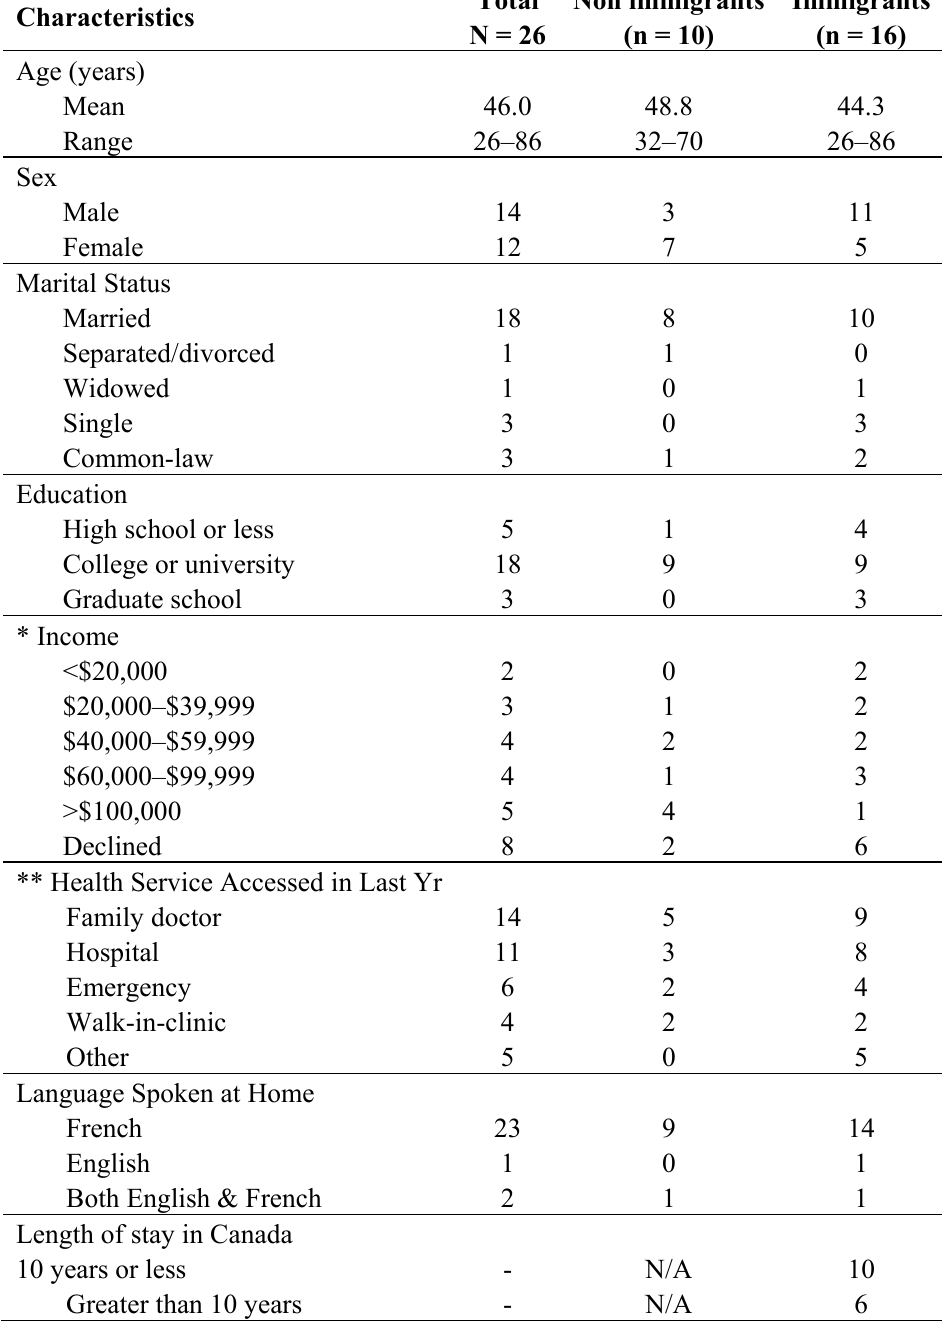
Table 1. Sample distribution of participants by immigration